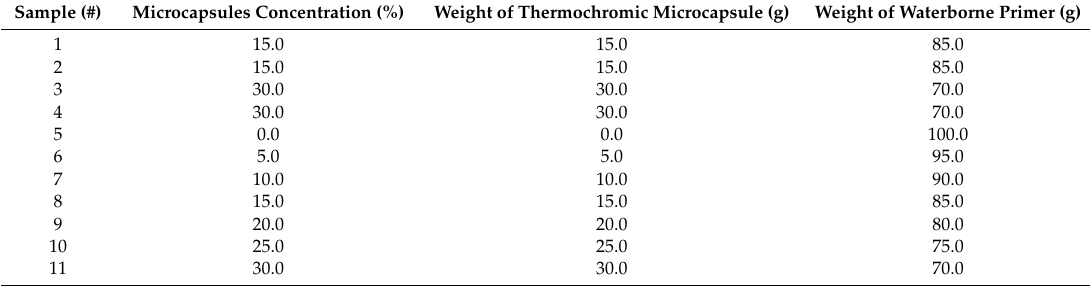
Table 2. Ingredient of waterborne coating added with thermochromic